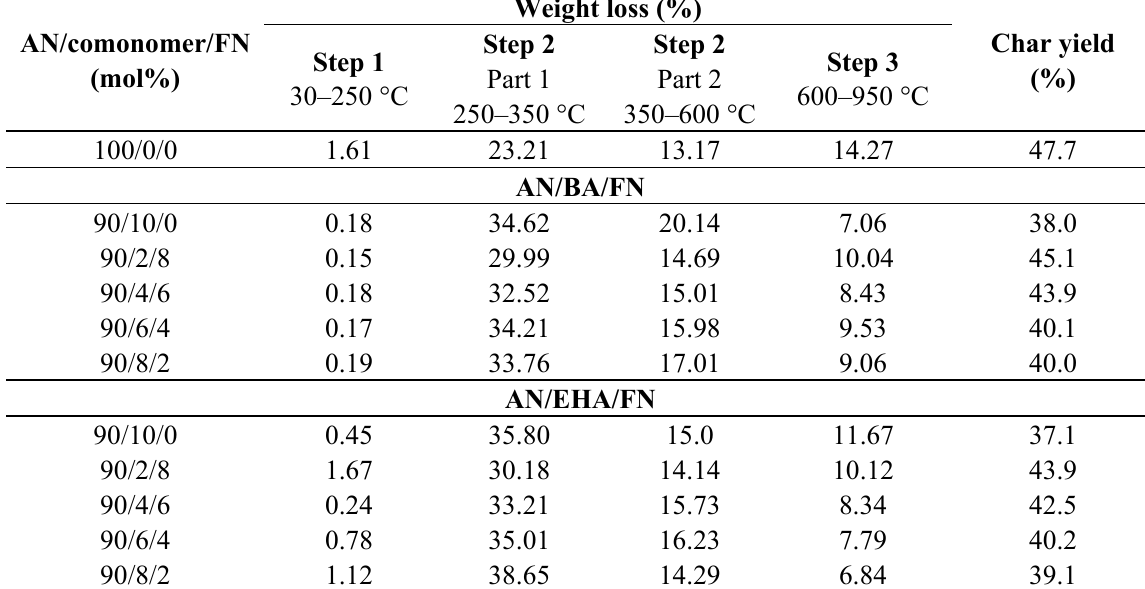
Table 4. Char yields of PAN homopolymer, copolymers and terpolymers.